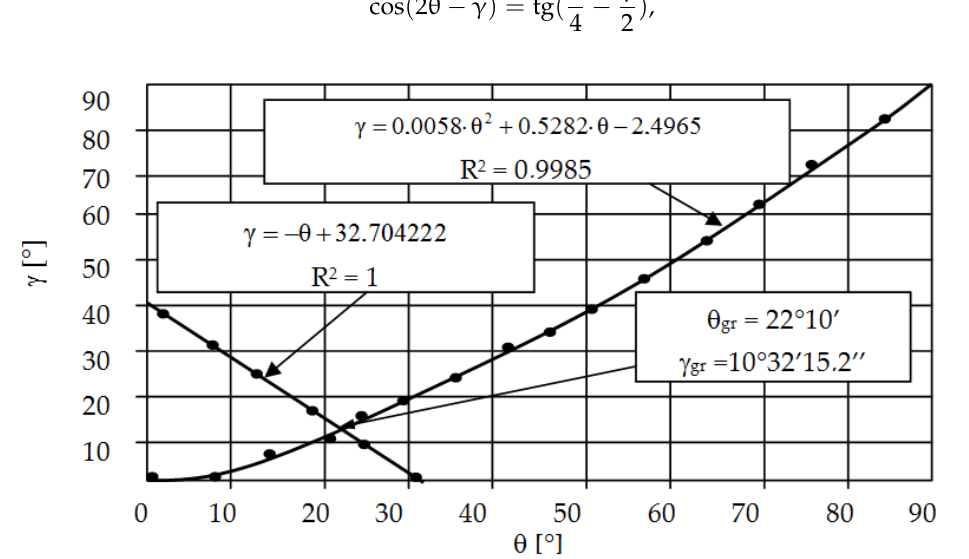
Figure 9. Graphs 𝛾 = f(θ) and assignment of border angle θ gr . Figure 9. Graphs γ = f ( θ ) and assignment of border angle θ gr .